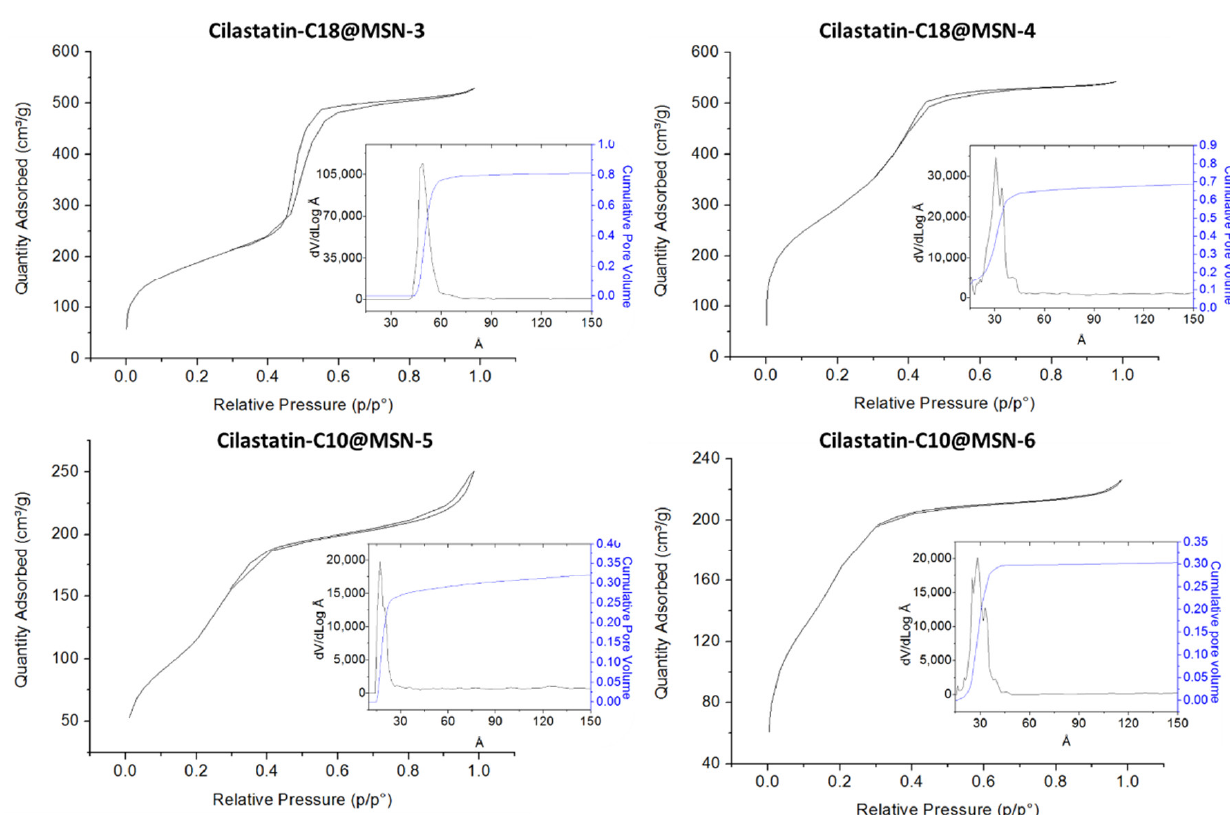
Figure 3. N 2 adsorption–desorption isotherms and pore size distributions (PSD) based on a NLDFT model of Cilastatin-C18@MSN-3, Cilastatin-C18@MSN-4, Cilastatin-C18@MSN-5, and Cilastatin-C18@MSN-6. Table 2. Mesoporous silica nanoparticles textural properties of cilastatin-C10@MSNs and cilastatin-C18@MSNs.